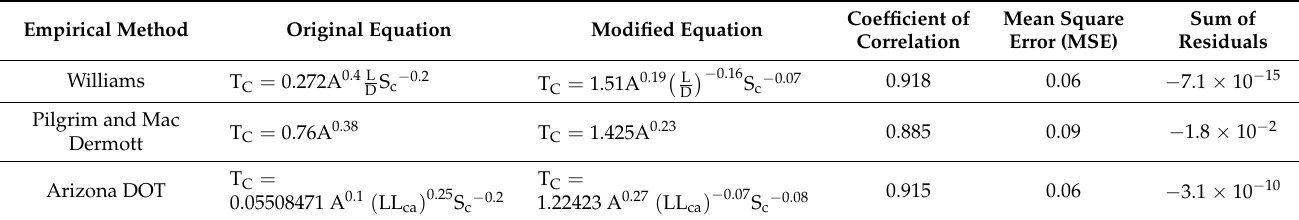
Table 8. Modified equations of top three empirical methods for estimating Tc in the sub-watersheds of central parts of Hormozgan